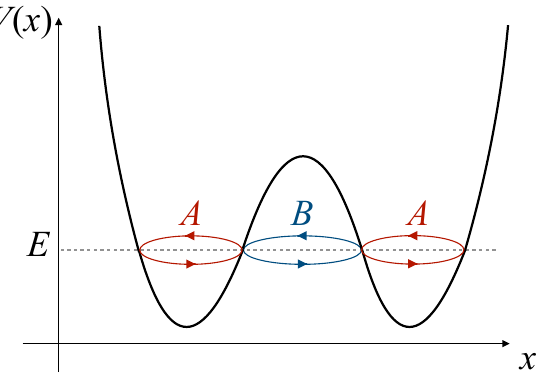
Figure 8 . Relationship between a periodic orbit and the Maslov index for the symmetric double- well potential. The index ( − 1) n is determined by counting D − 2 includes two infinite number of A -cycles ( D − 1